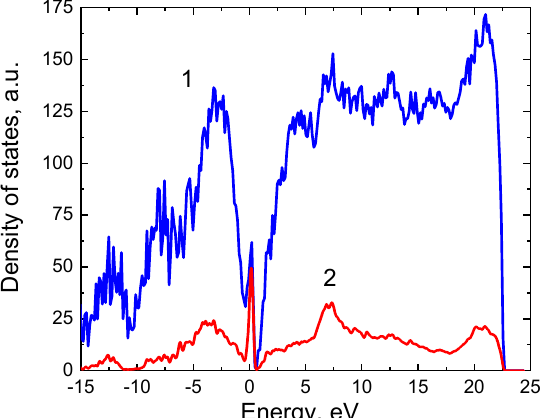
Figure 7. Dependence of the density of electronic states of the system under study on energy (curve 1). The Fermi energy corresponds to 0. Curve 2 is the contribution of p-electrons of those Si atoms at the SiC boundary that do not form bonds with the Si atoms of the substrate (highlighted in red in Figure 6 and by arrows in Figure 8).